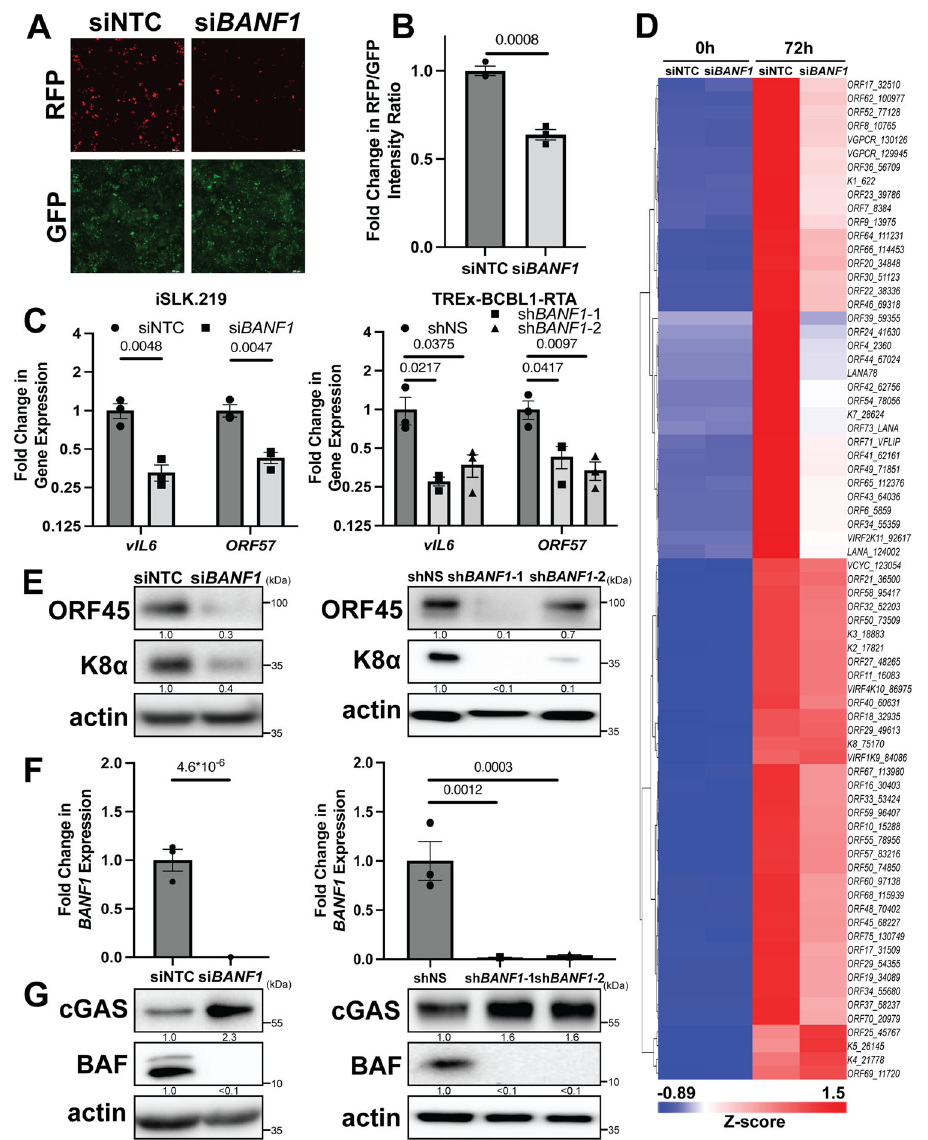
Fig. 1 | BAF is required for optimal KSHV reactivation from latency. iSLK.219 cells were transfected with non-targeting control (NTC) siRNA or BANF1 targeting siRNA 48h prior to the addition of 25ng/mL doxycycline. TREx-BCBL1-RTA cells weretransducedwithlentiviralshRNAfor72hpriortotheadditionof 1000ng/mL doxycycline. A Fluorescent microscopy imaging of iSLK.219 cells for RFP and GFP signal at 72h post-doxycycline treatment. B The fl uorescence was quanti fi ed by expressionpro fi lingwasperformed.DatashownaretheZ-scoreofthefoldchange